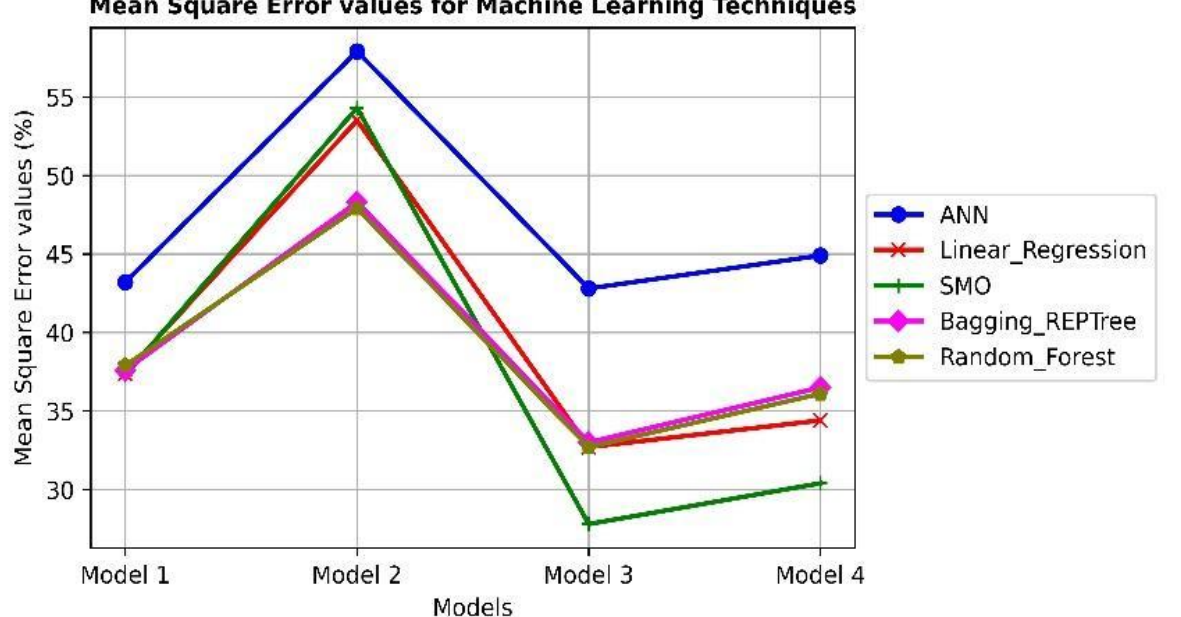
Figure 2. The results of using ML techniques on the SANAD App dataset R 2 .